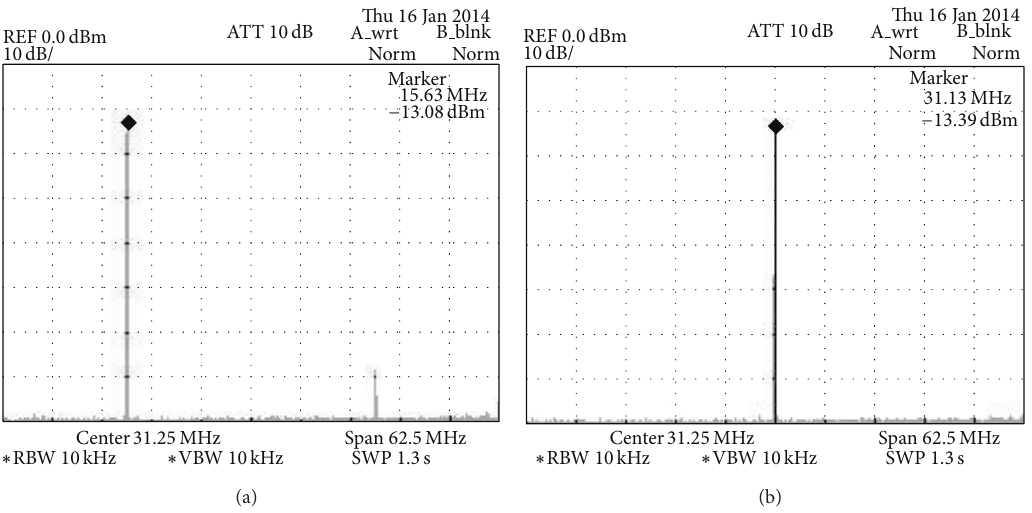
trigonometric identity were used to reduce the ROM size. The ROM was compressed to only 368 bits, with a 534.2 : 1